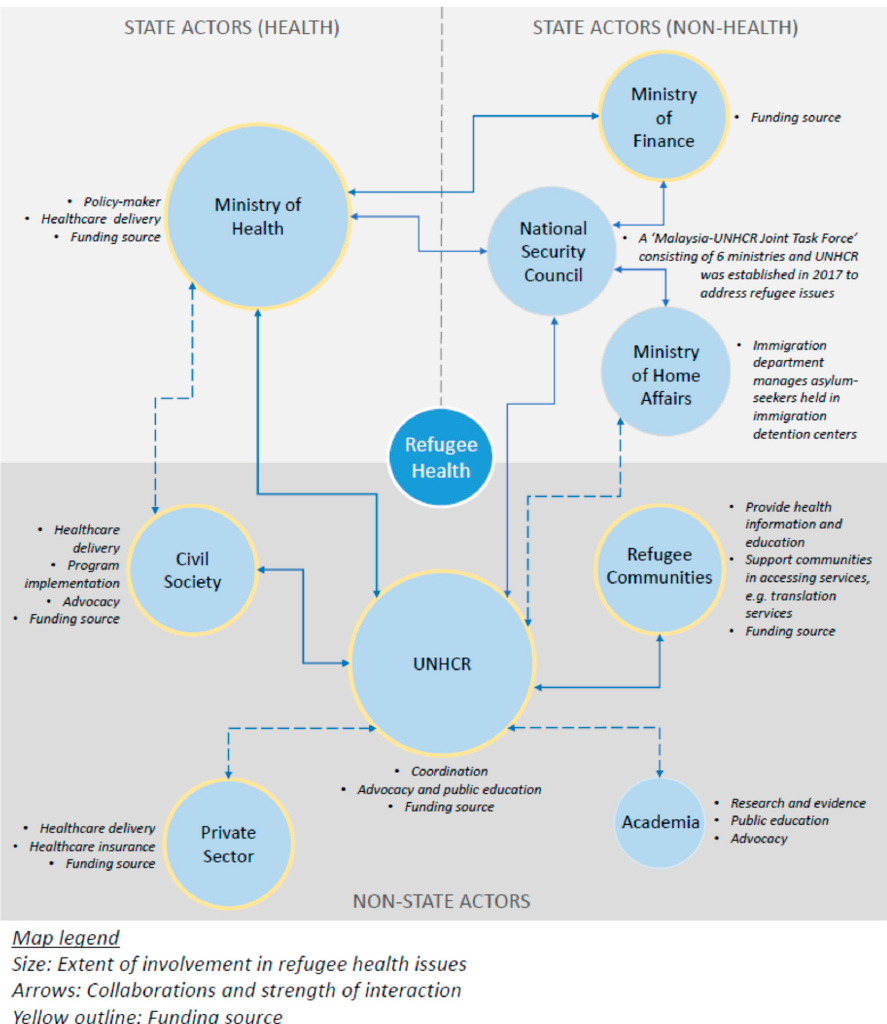
Figure 1. Stakeholder mapping of refugee health actors in Malaysia.